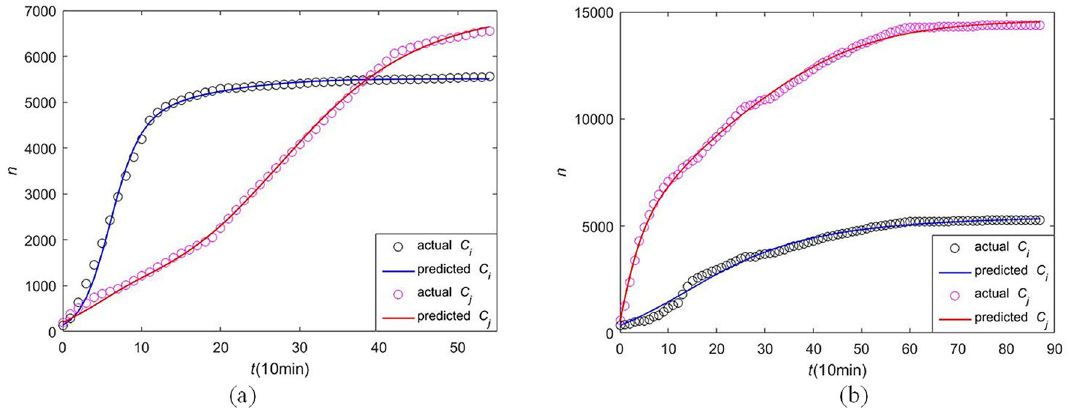
Figure 11. Numerical data fitting results of two public hot events. ( a ) event 1 in Table 2; ( b ) event 2 in Table 3. Where the black dot is the actual cumulative forwarding population and the blue line is the results of data fitting of information i ; the pink dot is the actual cumulative forwarding population and the red line is the results of data fitting of information j